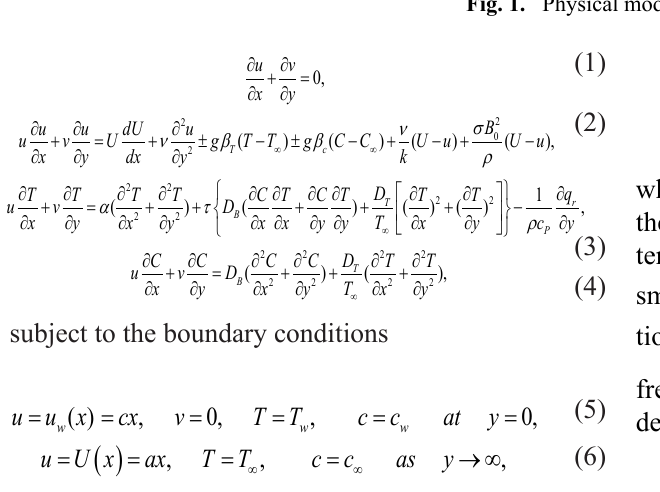
Fig. 1. Physical model and coordinate